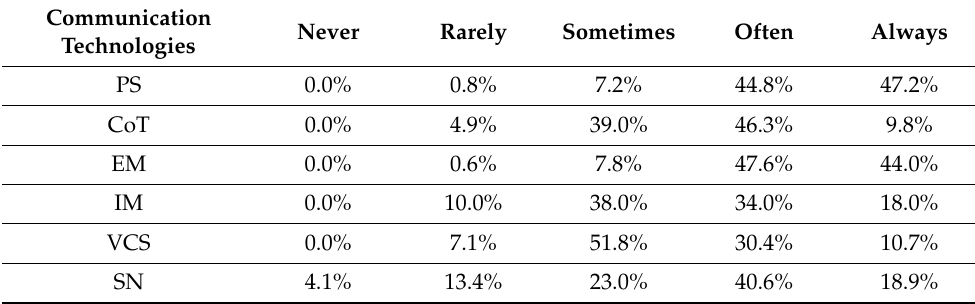
Table 20. Actual system usage of communication technologies by teachers.